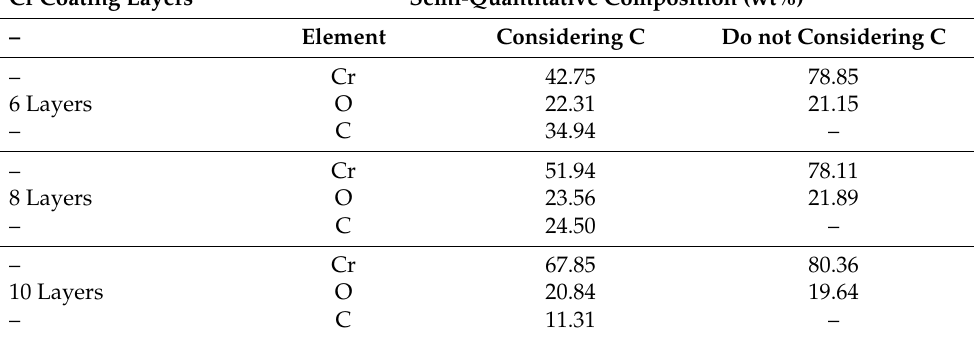
Table 2. Semi-quantitative analysis of the coatings composition carried out by energy dispersive spectroscopy